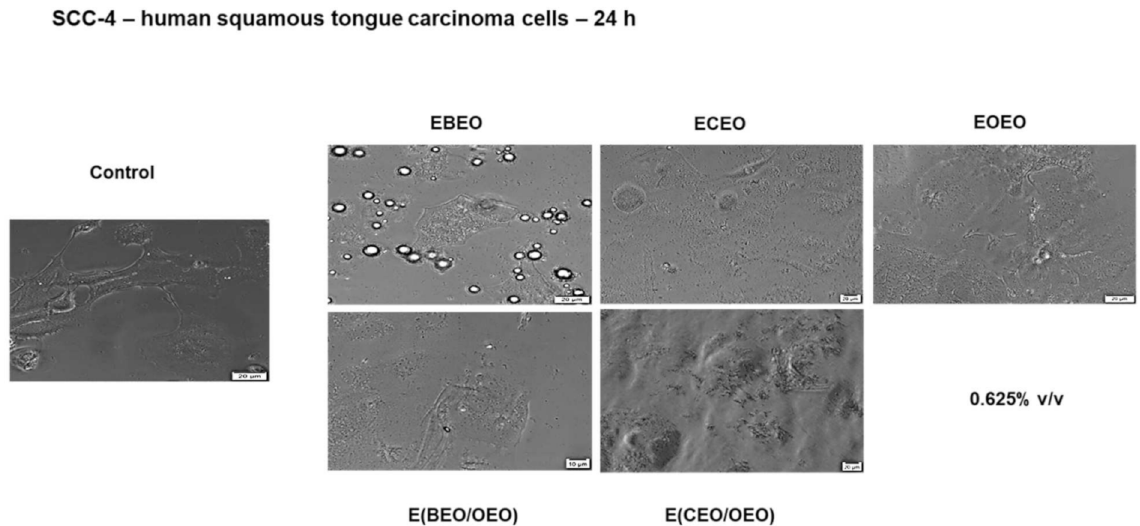
Figure 8. The morphological aspect of SCC-4 in culture: Control unstimulated cells and cells stimu- lated with different test compounds: ECEO, EOEO, EBEO, E(BEO/OEO), E(CEO/OEO) for 24 h. The scale bar is 20 µ